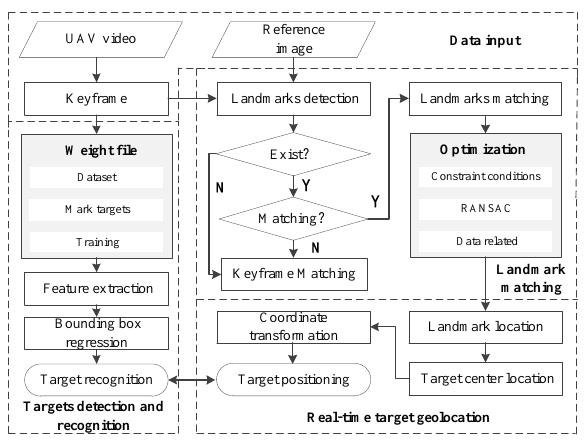
Figure 1. The major modules of proposed